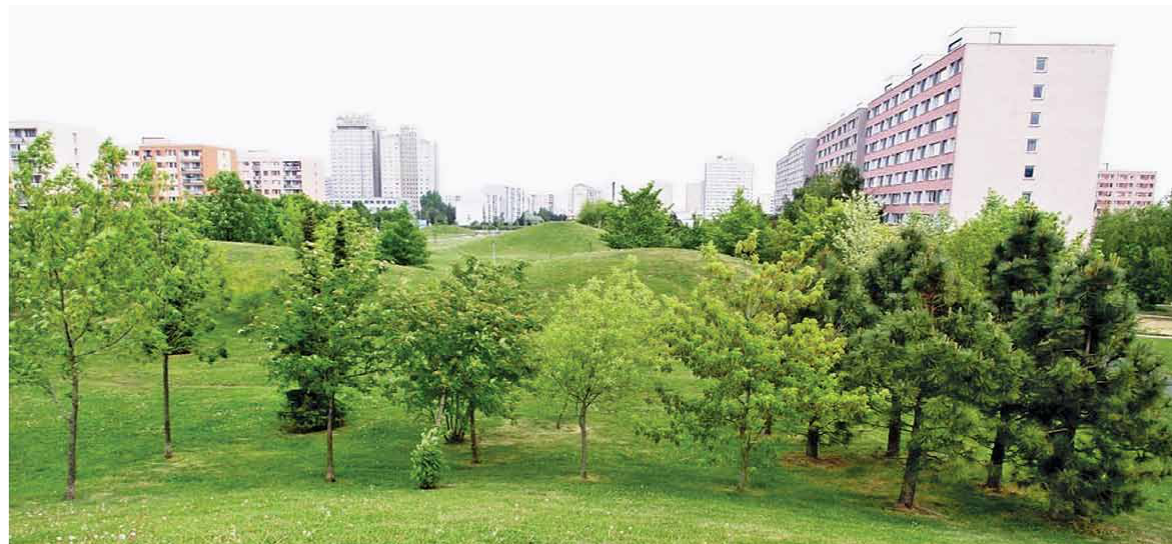
fig. 3. landscaping of the Central